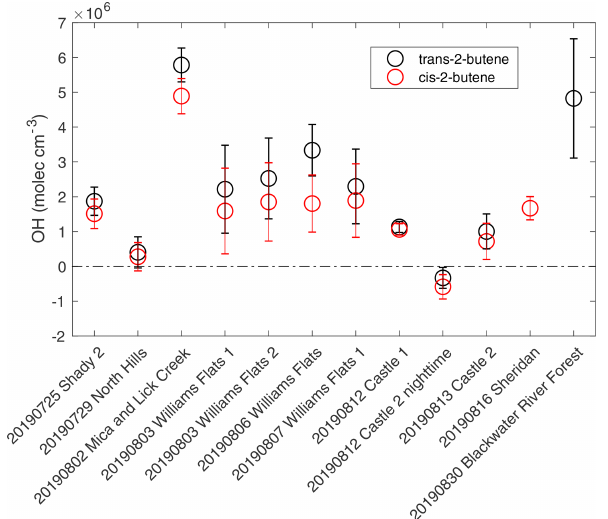
Figure 1. Estimated average OH concentrations for the plumes an- alyzed from the decay of trans-2-butene / propene (black) and the decay of cis-2-butene / propene (red). The error bars represent the propagated uncertainties from the slopes of butenes / propene decay and ozone variability within the